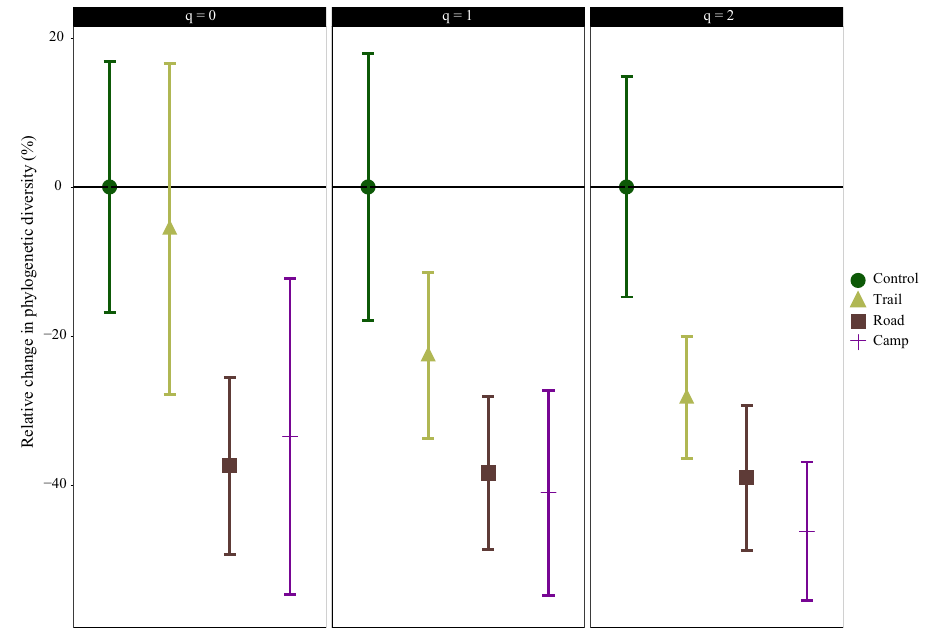
Figure 5. Relative change in phylogenetic diversity in different plant communities along transects in the Khorshid Park compared with the control community value. The phylogenetic diversity at the level of rare (q = 0), frequent (q = 1) and dominant (q = 2) plants are presented. The error bars are 95% confidence intervals, obtained from a 999 bootstrapping